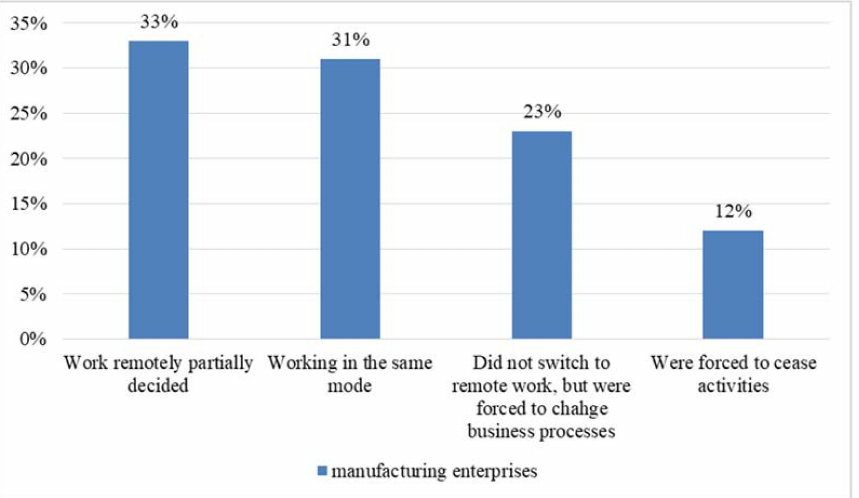
Figure 6. Consequences of the impact of the global COVID-19 pandemic on activities of manufactur- ing enterprises of the Republic of